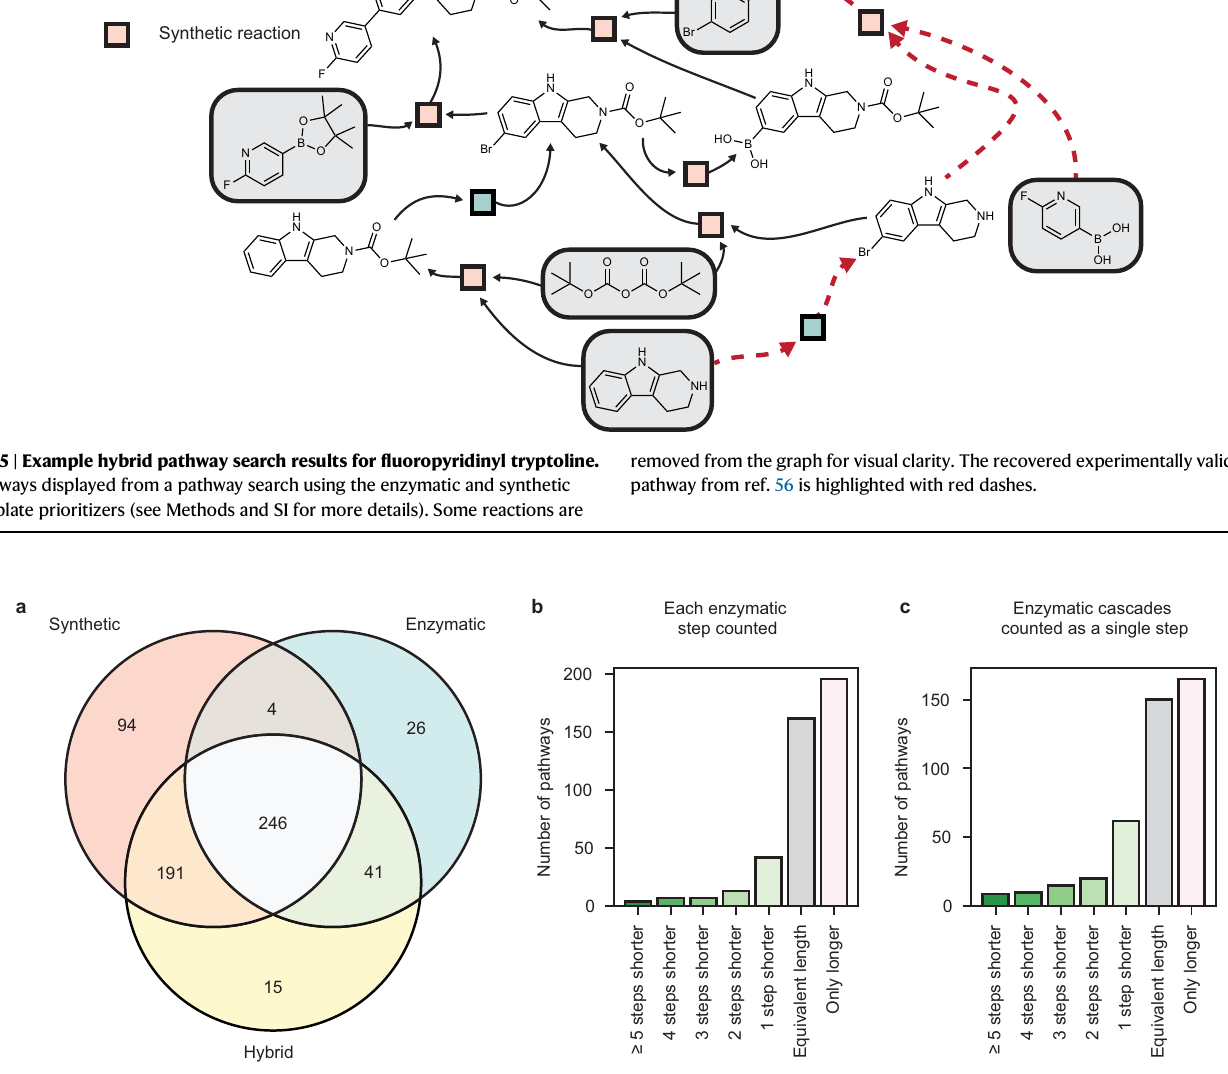
Fig. 6 | Comparison of routes found with hybrid and single-model searches. a Number of molecules for which synthesis routes were found out of 1000 mole- cules randomly sampled from the ZINC “ boutique ” subset. Each pathway search was performed with the same parameters using only the synthetic template prioritizer,onlytheenzymatictemplateprioritizer,orbothtemplateprioritizersat